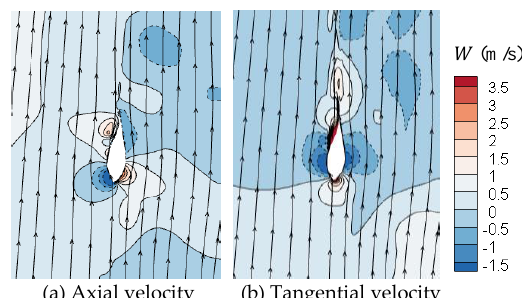
Fig. 16. Contour plots of axial (a) and tangential (b) components of 𝑈 𝑎𝑝 at r/R = 0.7 for a surging turbine for minimum 𝑈 𝑎𝑝 . Streamlines of the resultant velocity 𝑊 at the blade cross-section are. The axial velocity is positive from left to right and the tangential flow is positive going downward.